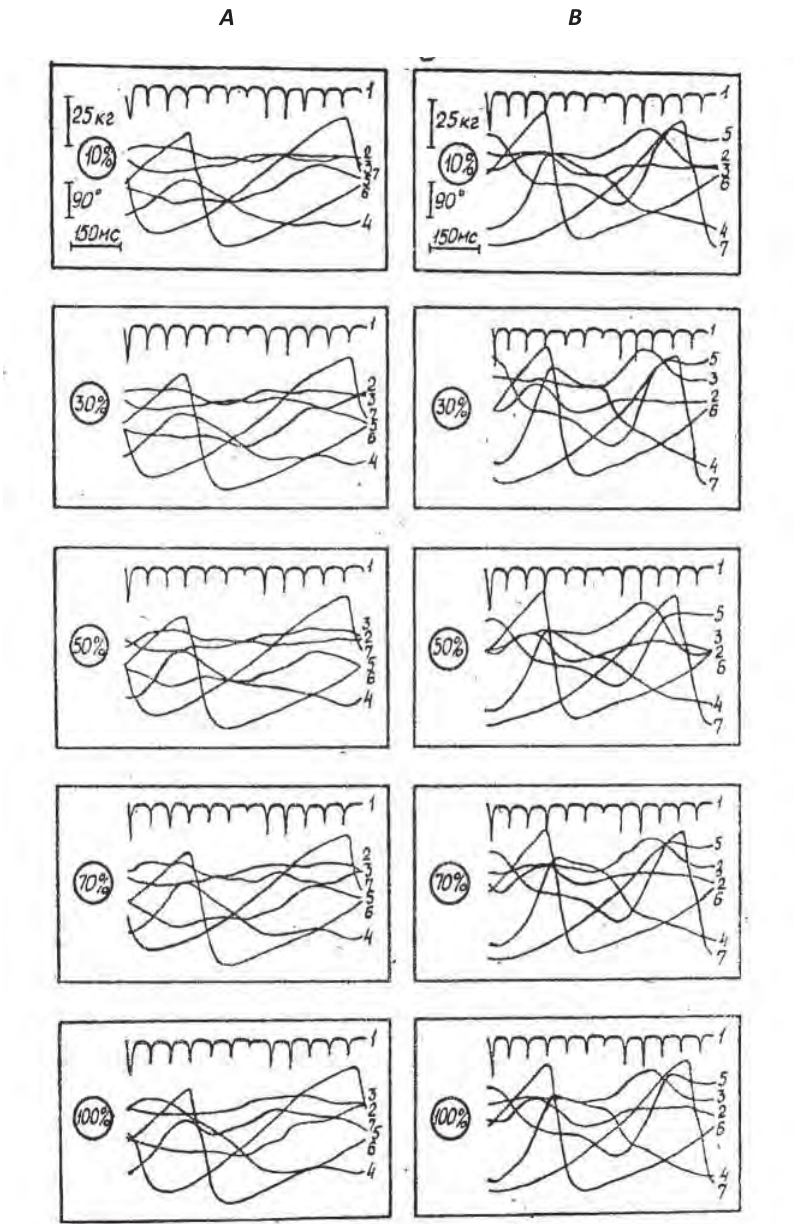
Fig. 2. Tenso-dynamic graphs of elite cyclists’ forces in model racing: А – honored master of sports V. K-ts, В – international master of sports D. L-sh. 1 – marker of rod position; 2 – horizontal forces of right leg; 3 – horizontal forces of left leg; 4 –vertical forces of right leg; 5 –vertical forces of left leg; 6 – goniogram of angle between pedal and rod (right leg); 7 – goniogram of angle between pedal and rod (left